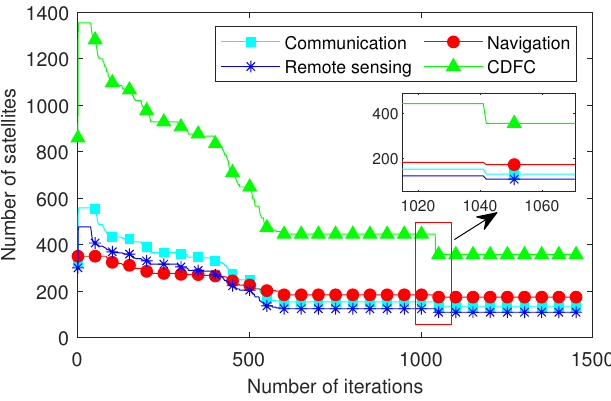
Figure 3. Convergence process diagram of decision variable optimization.